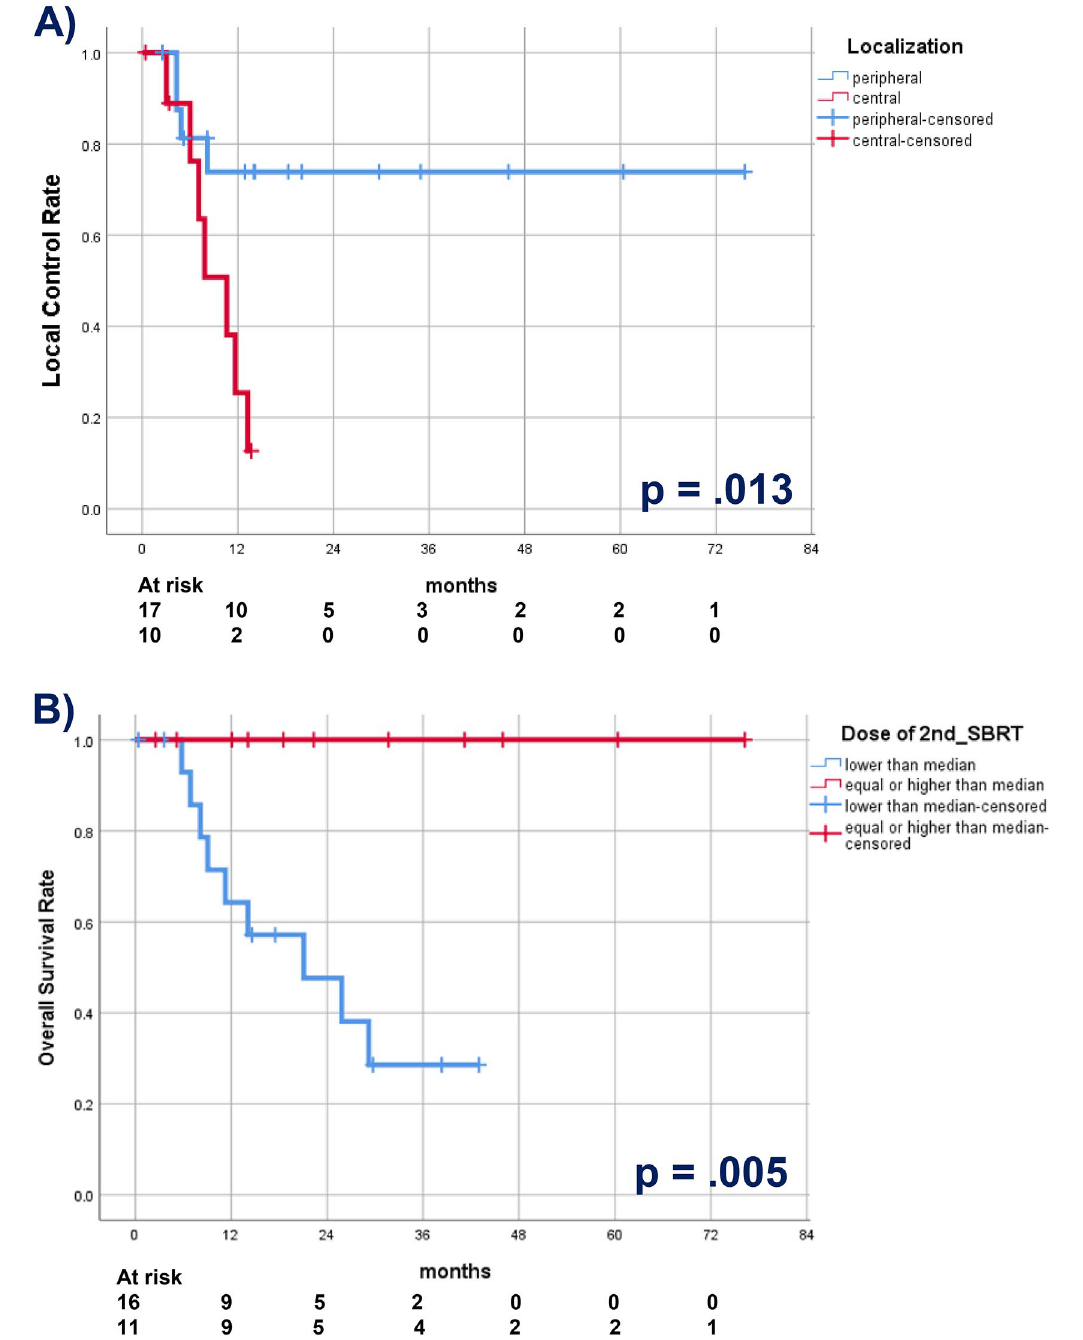
Figure 3. Kaplan–Meier curves demonstrating the significant impact of ( A ) tumor localization on local control rate and ( B ) dose of the 2nd SBRT course on survival.